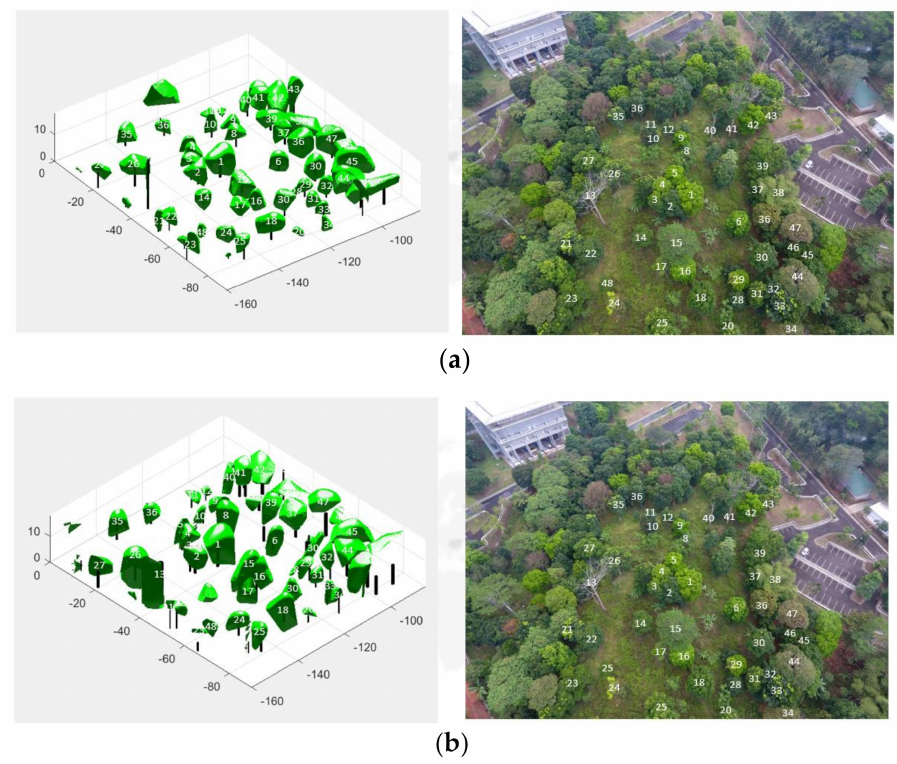
Figure 18. Comparison between the results of 3D modeling of trees using a spherical harmonics method on ( a ) photogrammetric data and ( b ) LiDAR data with the actual situation in the field